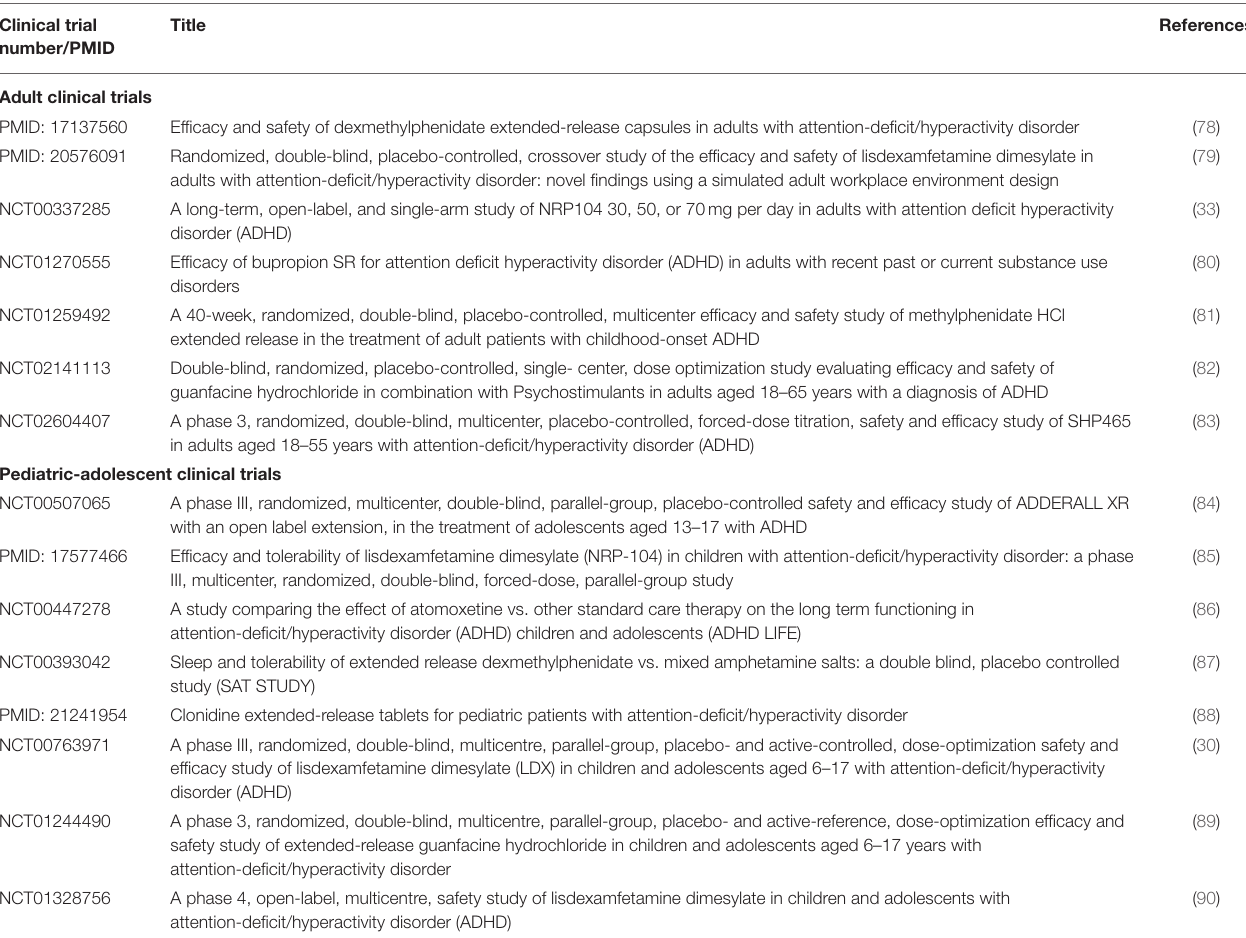
TABLE 3 | List of clinical trials used for attention-deficit/hyperactivity disorder model-derived efficacy measure optimization. Clinical trial